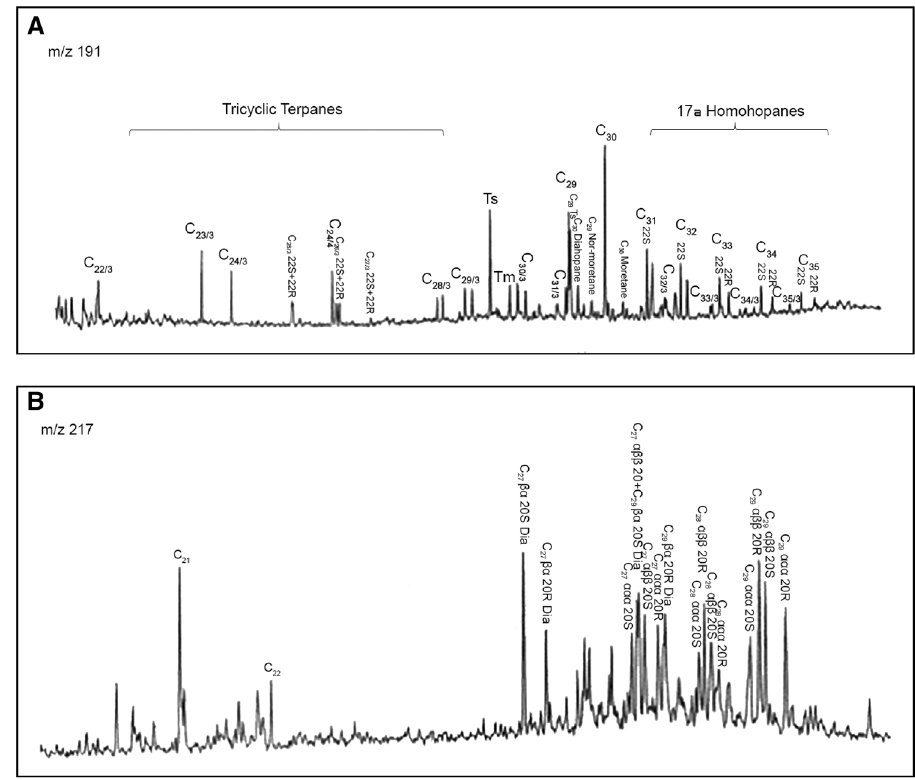
Fig. 8 Typical hopane ( a ) and